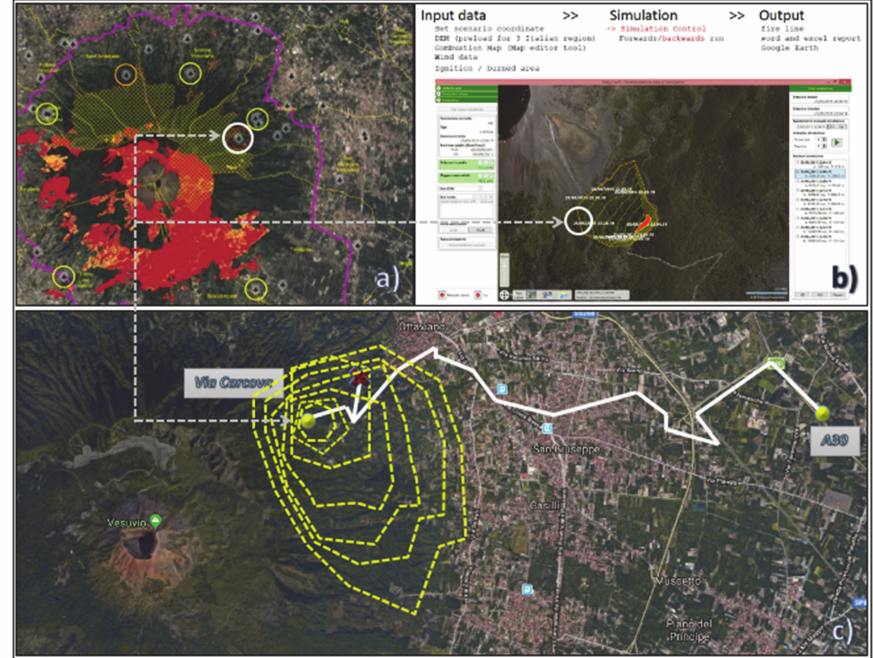
Figure 9. ( a ) mapping of the beekeepers’ farms in Mount Vesuvius’ red zone; ( b ) example of the TIGER simulation tool; ( c ) evaluation of the OPERA for a beekeeper farm.